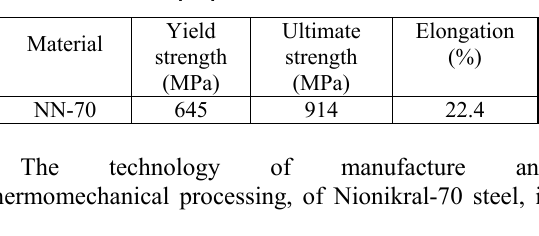
Table 2. Mechanical properties of NN-70